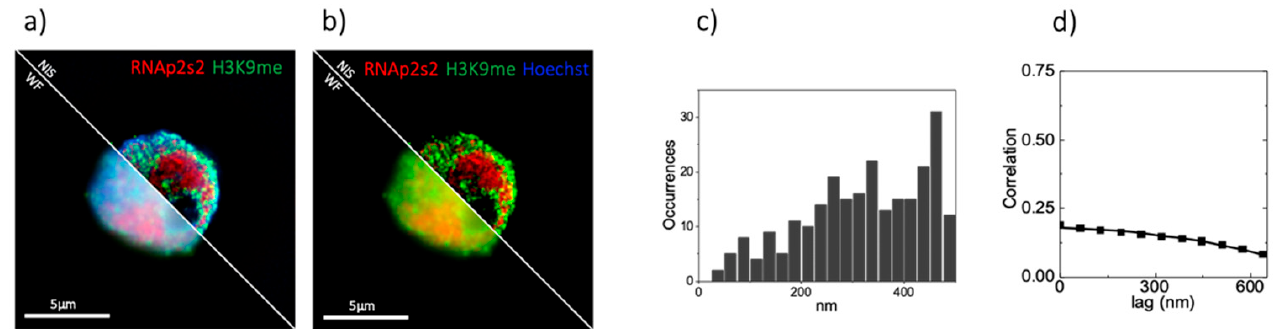
Figure 6. Biological sample of non-colocalizing nuclear markers . ( a ) Comparison between three color WF and SIM acquisition of PR9-U937 cell line. DNA is stained in blue by using Hoechst, gene silencing is stained by labeling H3K9me2 in green, active transcription is marked by labeling RNApol2ser2P in red. ( b ) Two color considered for the colocalization analysis, H3K9me2 and RNApol2ser2P. ( c ) Object based analysis on the sample shown in ( b ). ( d ) ICCS analysis performed on the sample shown in ( b )